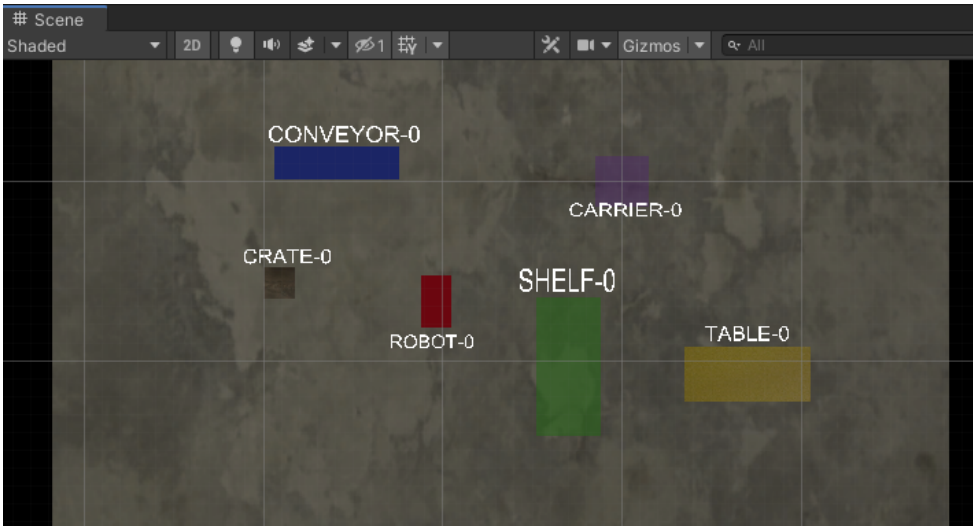
Figure 3. Example of a 2D map as output of the second step of the proposed